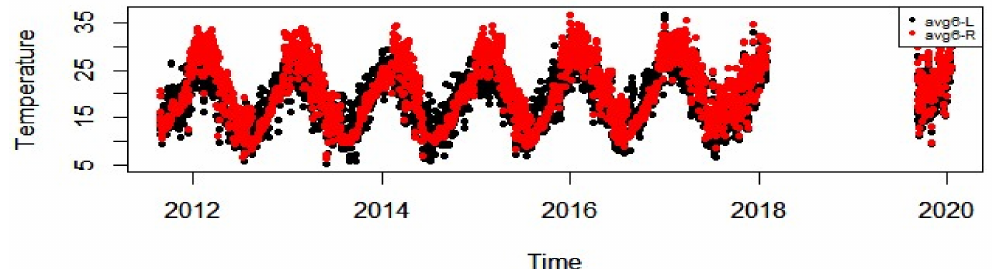
Figure 11. Avg6-R against avg6-L (Temperature in ◦